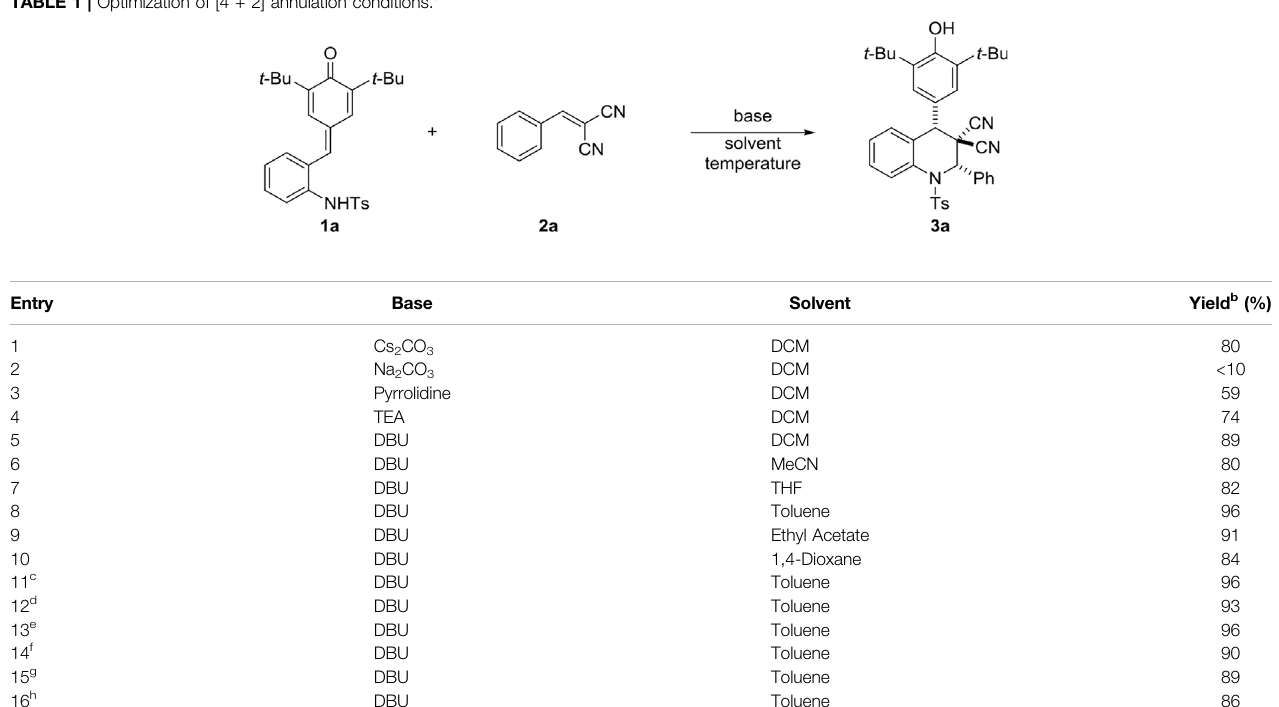
TABLE 1 | Optimization of [4 + 2] annulation conditions.